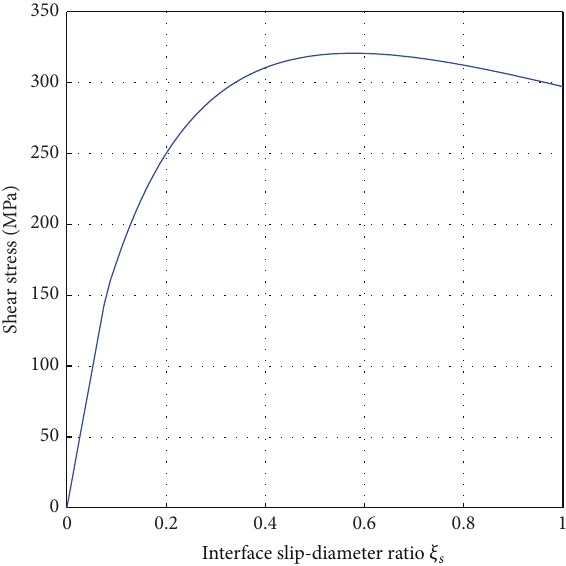
Figure 6: The curve of 𝜉 𝑠 to shear stress of single steel bar in compression zone.